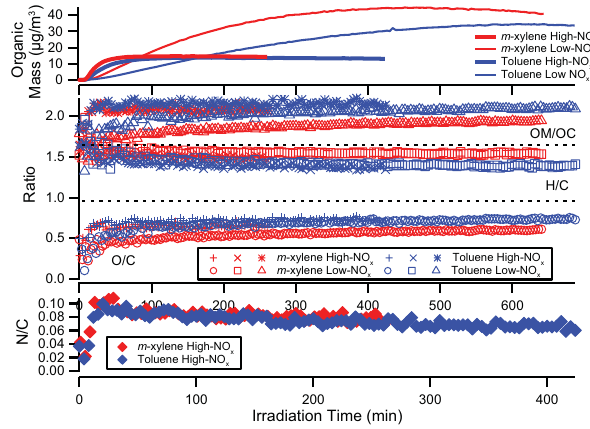
Fig. 8. AMS organic mass (not corrected for collection efficiency), elemental ratios, and OM/OC for single-ring aromatic experiments. Dotted lines are provided to visually separate different